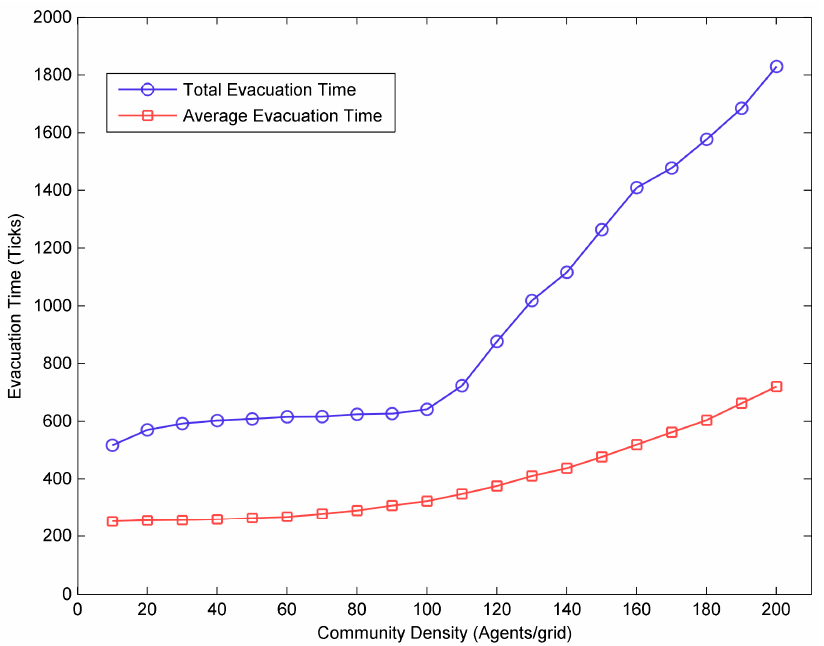
Figure 5. The impacts of community density on the total evacuation time.